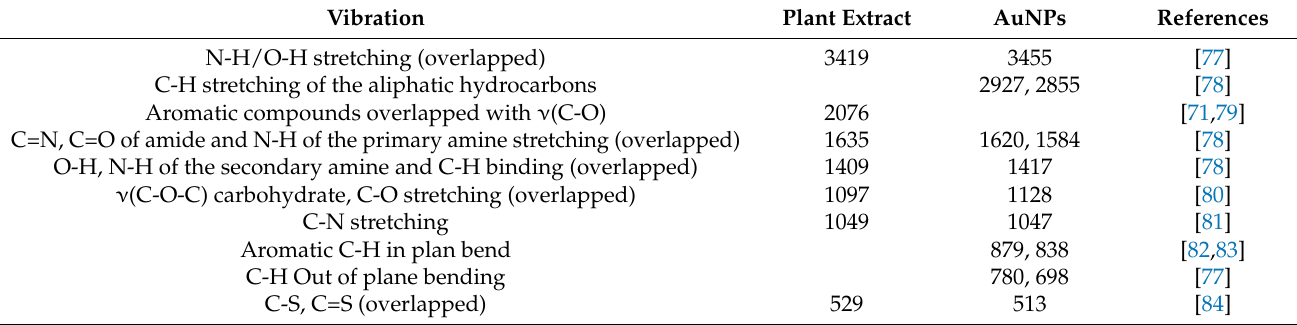
Figure 4. Characterization of materials. ( A ) UV-Vis spectrum of AuNPs (before and after purification); ( B ): FT-IR spectra of plant extract (aqueous extraction) and as-formed AuNPs. Table 2. Assignment of peaks of plant aqueous extract and as-formed